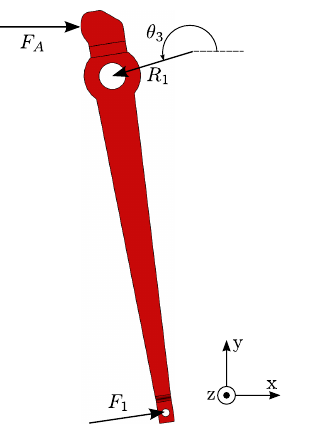
Figure 11: Free Body Diagram of the axial load setup.